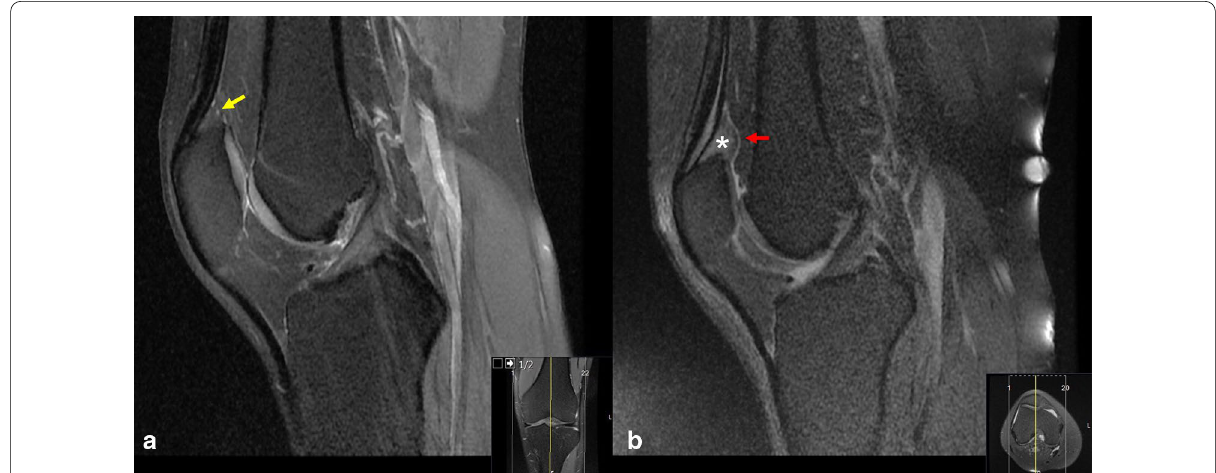
Fig. 2 a Appearance of normal quadriceps fat pad (yellow arrow). b A patient with QPFIS. The sagittal fat-saturated, proton-density-weighted MRI demonstrates typical convex appearance (red arrow) and increased signal and thickening within quadriceps fat pad (white